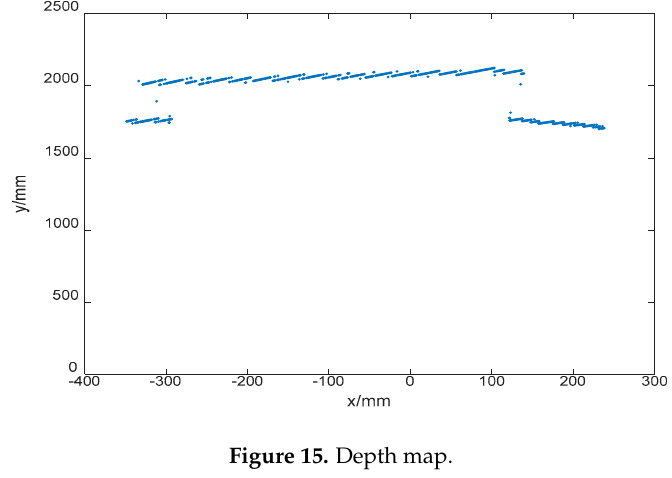
Figure 15. Depth map.